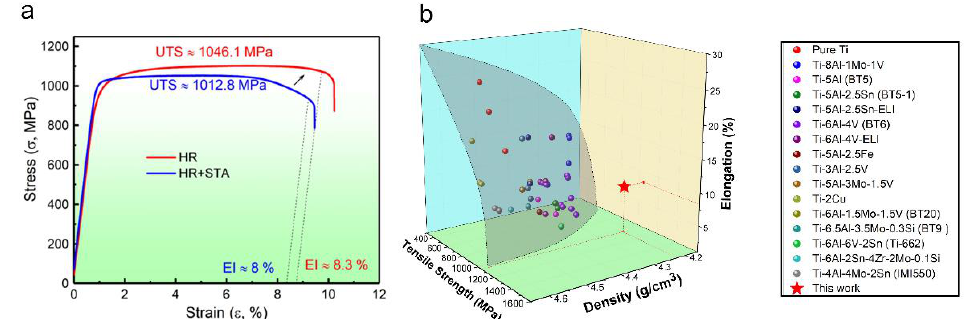
Figure 5. ( a ) Representative engineering stress – strain curves of the hot-rolled and heat-treated LD-Ti423 alloy; ( b ) comparison of the tensile strength, elongation, and density of LD-Ti423 alloy with other typical commercial Ti alloys. The red five-star in ( b ) represents the LD-Ti423 alloy. Table 1. Tensile property values of hot-rolled and heat-treated LD-Ti423 alloys.